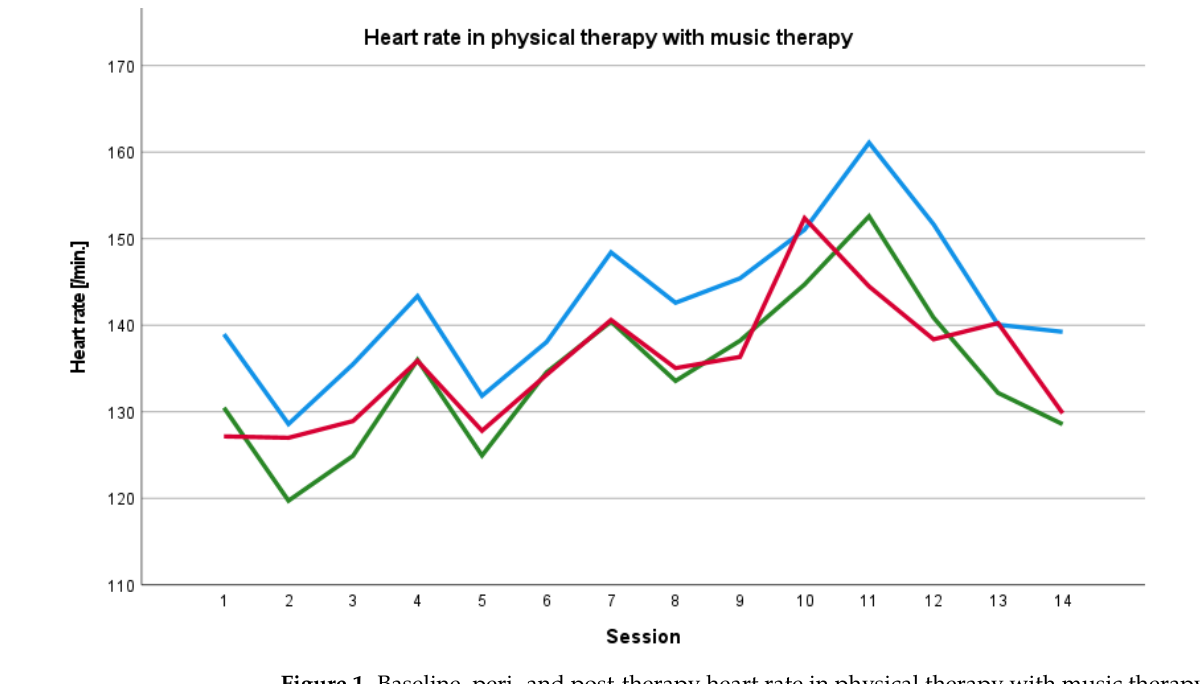
Figure 1. Baseline, peri- and post-therapy heart rate in physical therapy with music therapy. Blue line: mean baseline value, green line: mean peri-therapy value, red line: mean post-therapy value.